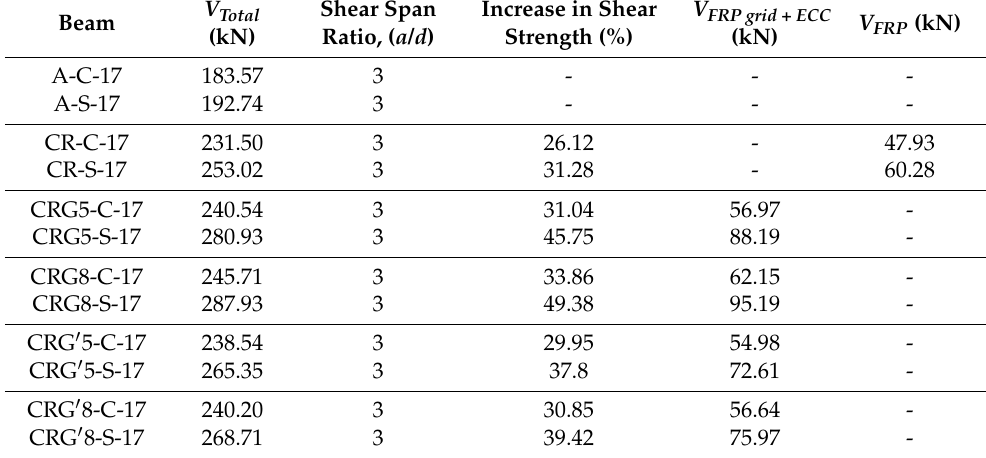
Table 9. Summary of shear capacity of beams.